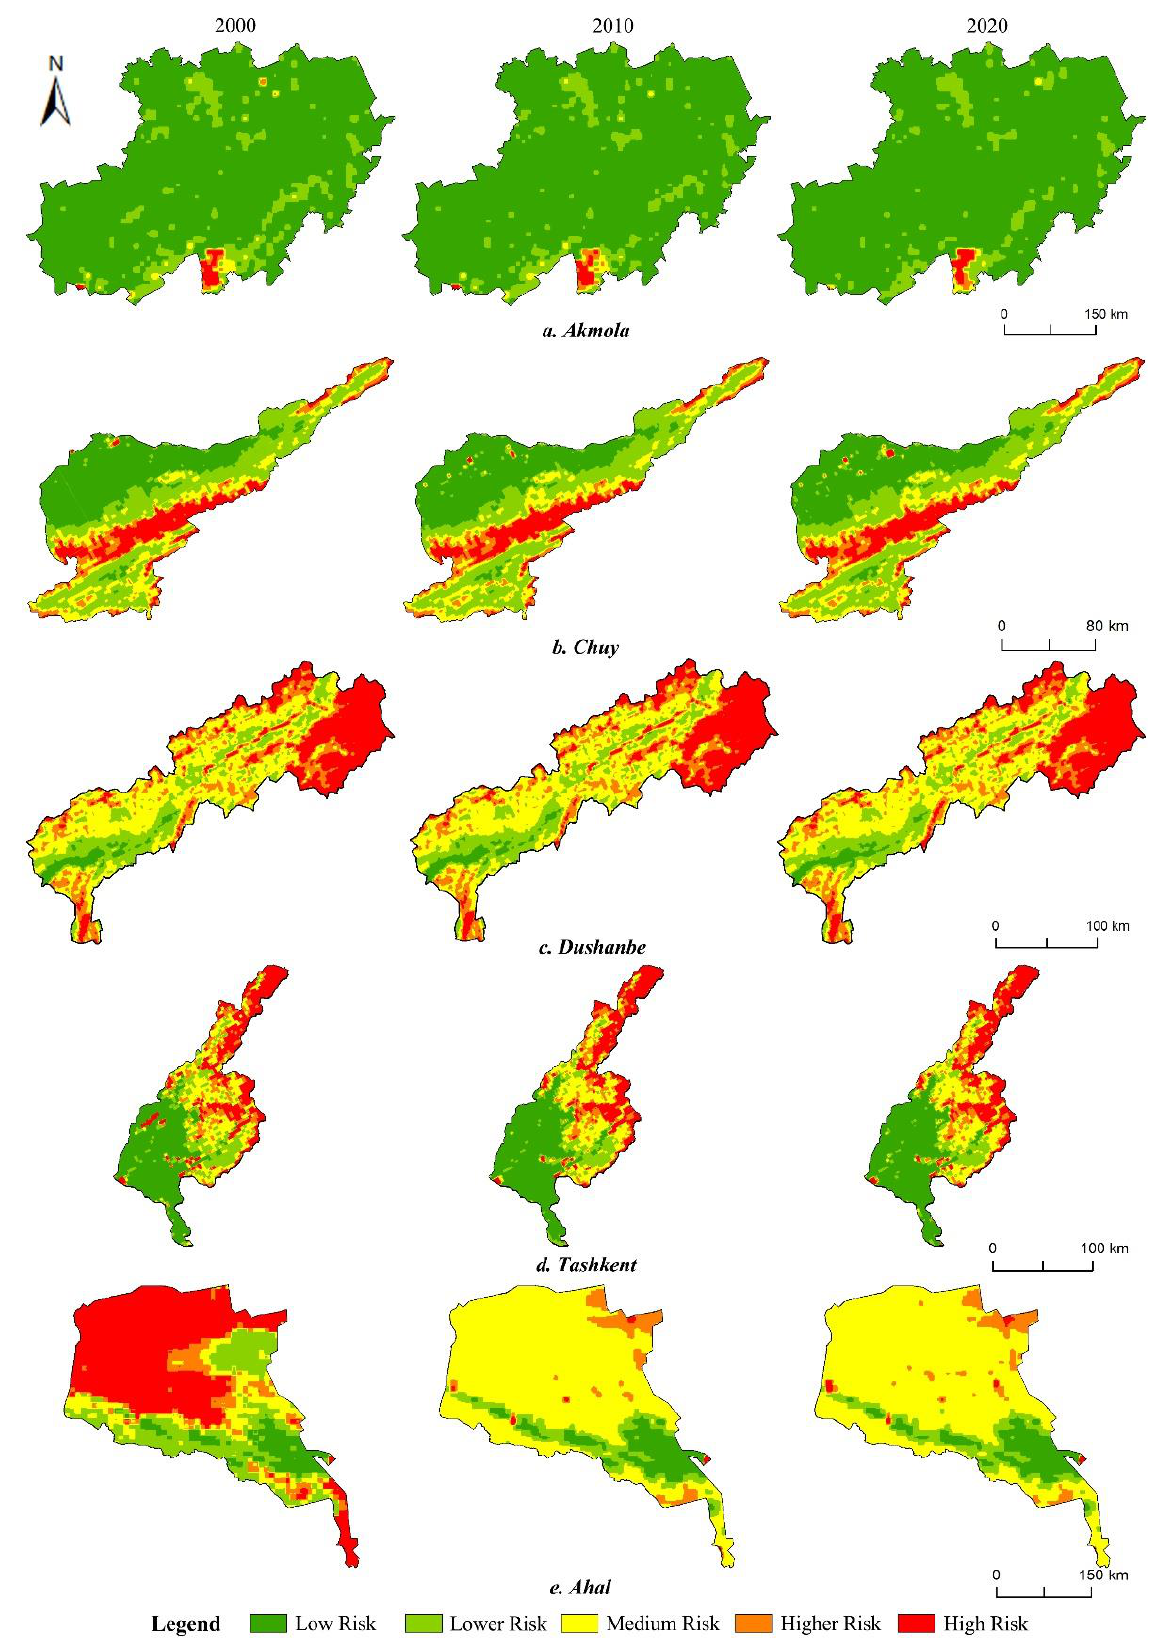
Figure 7. ( a – e ) Spatial distribution map of landscape ecological risk.